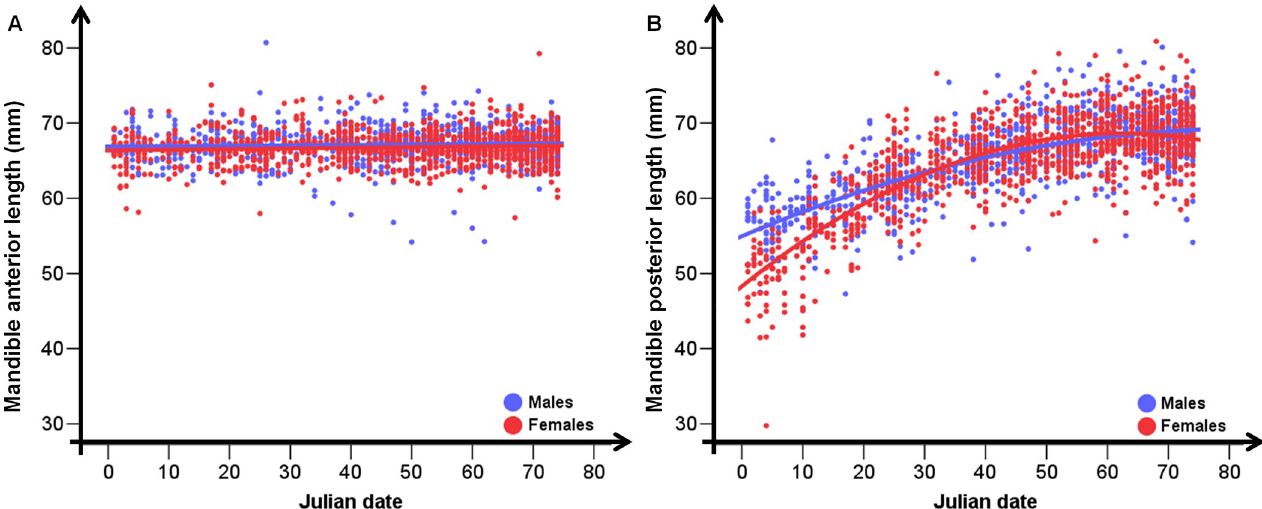
Fig 3. Mandible sections growth. Length of the anterior (A) and posterior (B) section of 2,161 mandibles of juveniles (8–10 months; 1,176 females and 985 males), collected during the 2013–2015 hunting seasons in the Arezzo province (Tuscany, Central Italy), in relation to the Julian date (1 st January-15 th March).